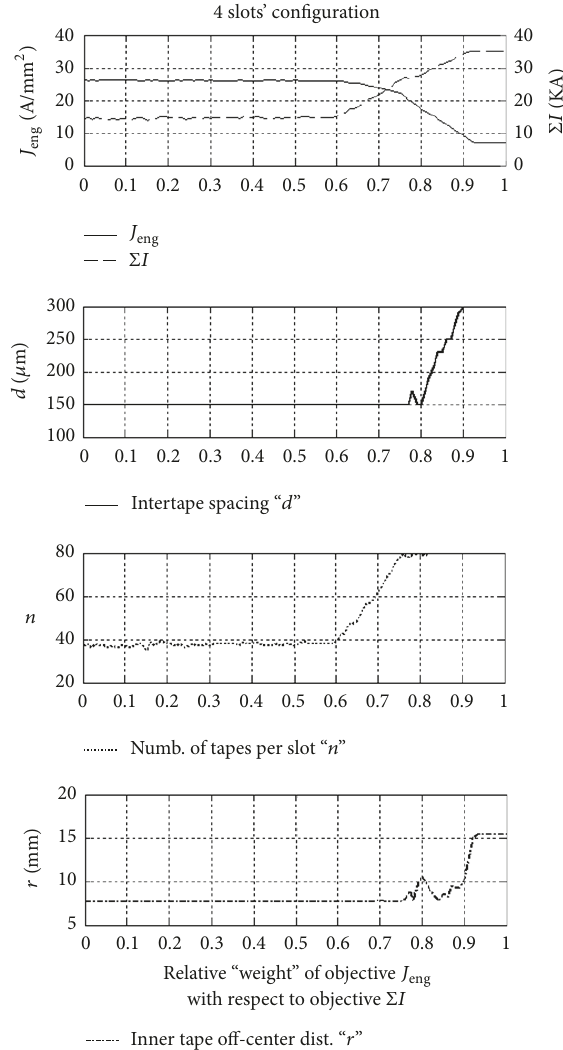
Figure 8: Pareto frontier represented as a function of the relative “weight” of one objective with respect to the other for the 4 slots’ = 4) . Top panel: values of the two objectives. configuration (𝑛 slots Bottom panels: values of the respective design